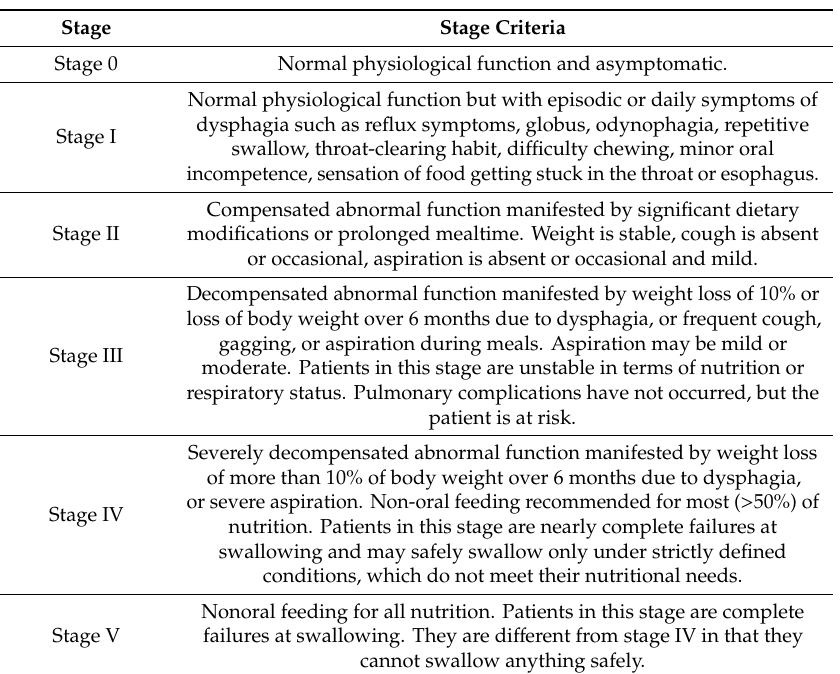
Table 2. Functional outcome swallowing scale for staging oropharyngeal dysphagia proposed by John R. Salassa in the 39th annual meeting of the American Society for Head and Neck